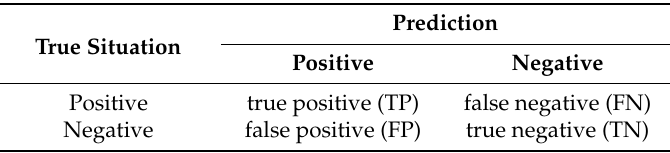
Table 2. The confusion matrix of